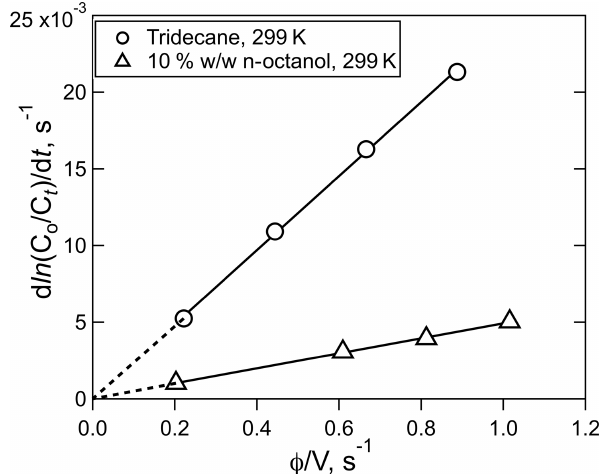
Figure 2. Plots of HNCO loss rate versus the ratio of volumetric flow rate, ϕ , to solution volume, V , for the experiment shown in Fig. 1 (circles), and the experiment with 10% w/w n -octanol in tridecane at 299K (triangles). The error bars in the individual rates were smaller than the width of the